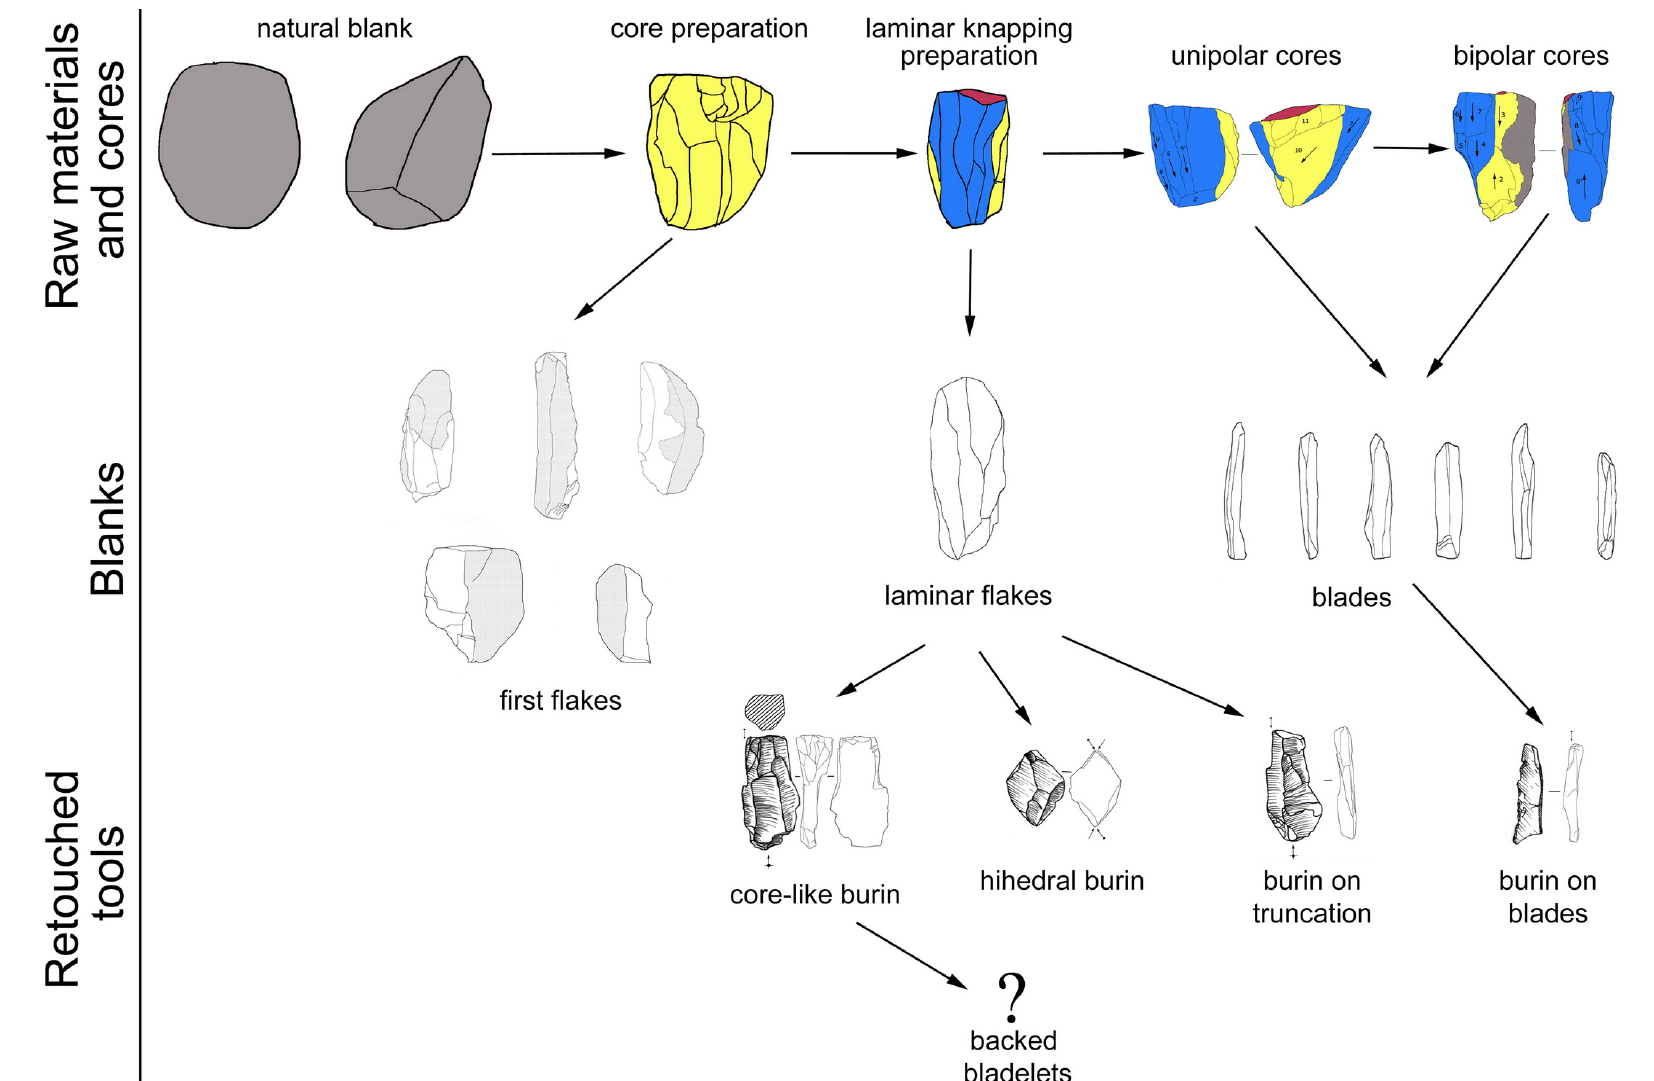
Figure 20. Debitage process of transformation from the lithic assemblage from Tajo de Journal of Lithic Studies (2016) vol. 3, nr. 2, p. 327-356